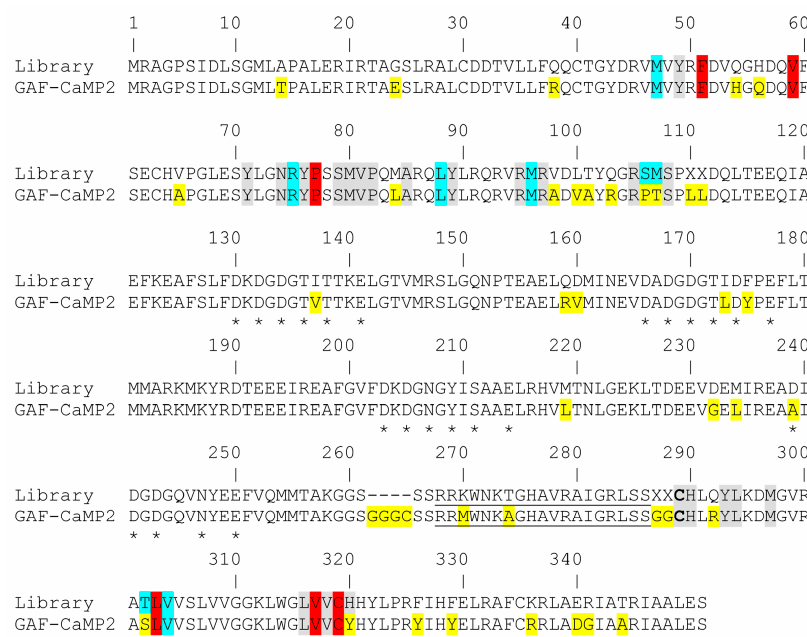
Figure 2. Alignment of the amino acid sequences for the original library L9 and GAF-CaMP2 calcium indicator. Alignment numbering follows that of original library L9. Mutations in GAF-CaMP2 related to the initial library L9 including linkers between fluorescent and indicator parts are highlighted in yellow. The residues which are suggested within 4.5, 4.5–5.5, and 5.5–6.5 Å surrounding the BV chromophore according to the X-ray structure of PaBphP (3C2W) are highlighted in grey, cyan, and red colors, respectively. Residues in the CaM-part that assumed to bind Ca 2+ ions are selected with stars. M13-peptide is underlined. Cys-residue 289 that is suggested to be covalently bound to the chromophore of GAF-FP protein is selected with bold.